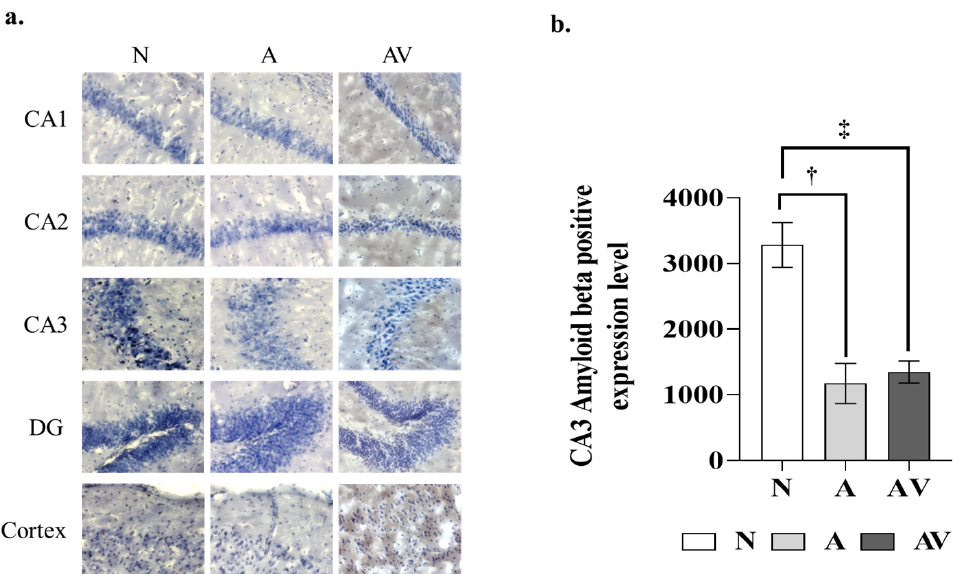
Figure 2. Amyloid-beta expression in ApoE4-KI mice after auditory and audiovisual stimulation.